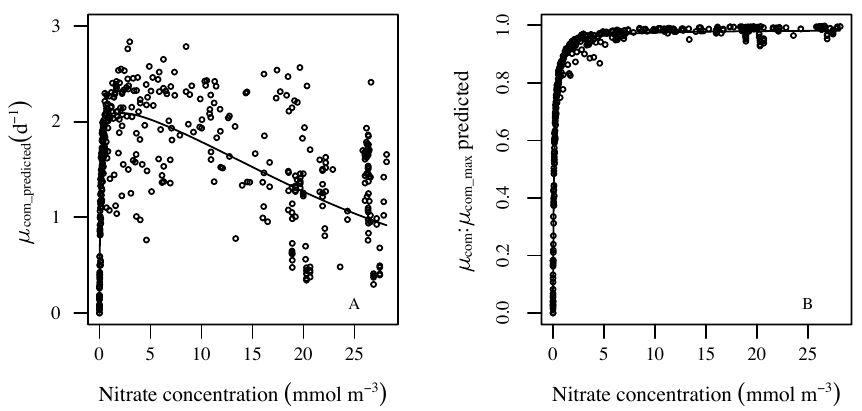
Figure 5. Relationships between (a) predicted community growth rate ( µ com_predicted , d − 1 ) and (b) predicted µ com : µ com_max ratio, and nutrient concentration (mmolm − 3 ). The solid lines represent the nonlinear least square fits.